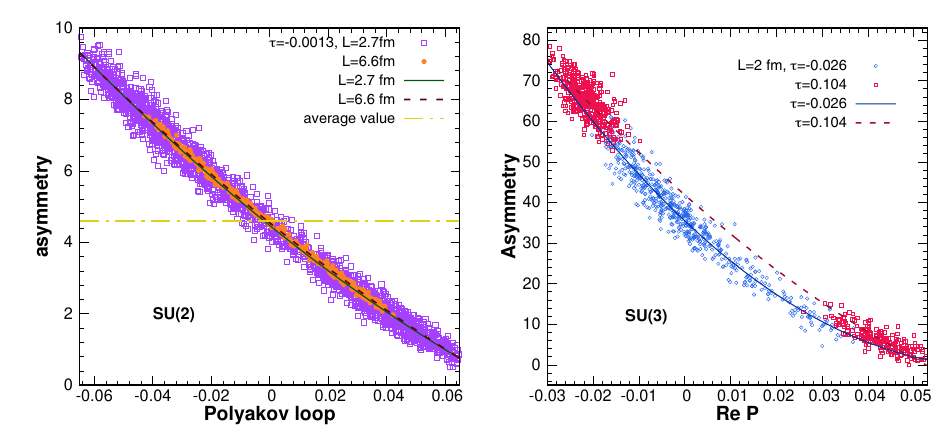
Figure 3: Scatter plots illustrating correlation between the asymmetry and the Polyakov loop. Data are shown at two di ↵ erent lattice sizes and the same temperature in the SU(2) case (left panel) and at two di ↵ erent temperatures and the same lattice size in the SU(3) case (right panel). Shown lines are the regression curves based on the linear model (4). Figure 2: Scatter plots illustrating correlation between the zero-momentum longitudinal prop- agator and the Polyakov loop. On the left panel data are shown at two di ↵ erent volumes and the same temperature. Shown lines are the regression curves based on the linear model (3).